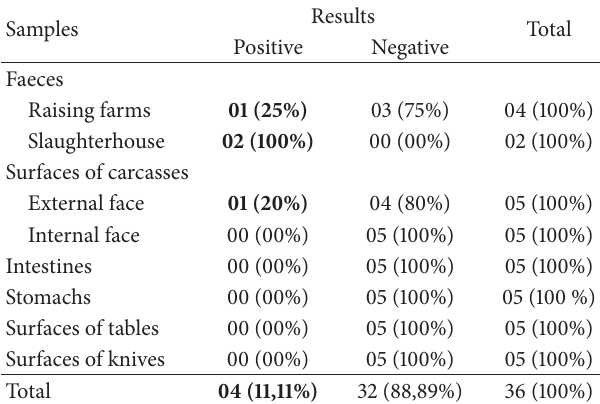
Table 4: Results of analyses of samples descending from the